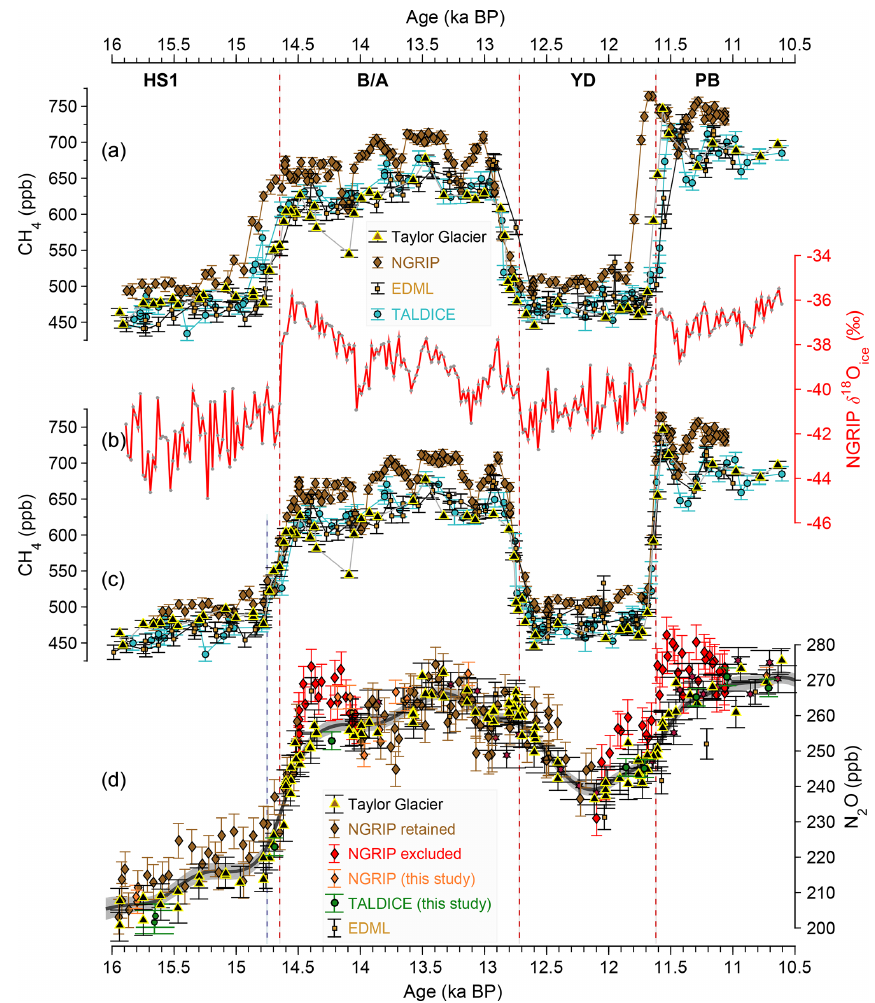
Figure 2. Methane synchronization of ice core records. (a) Existing methane (CH 4 ) concentration records for NGRIP and EDML (Baum- gartner et al., 2012), and TALDICE (Schilt et al., 2010b) shown on the original AICC2012 gas age scale. The fast climate variations indicated by the NGRIP δ 18 O ice record (b) (Rasmussen et al., 2006) were used as tie points for CH 4 changes in the NGRIP and TALDICE ice cores (mid points of the CH 4 changes indicated by vertical dashed red lines). The onset of the CH 4 increase at the end of HS1 is indicated by the blue vertical dashed line (see text). A similar approach had been taken by Schilt et al. (2010b) by synchronizing the fast changes in the Taylor Glacier CH 4 data with the corresponding changes in the WAIS Divide deep ice core CH 4 data on an updated version of the WDC06A-7 timescale. The synchronized CH 4 records (c) are then used to create a common gas age scale for N 2 O data on the GICC05 age scale (d) (Rasmussen et al.,